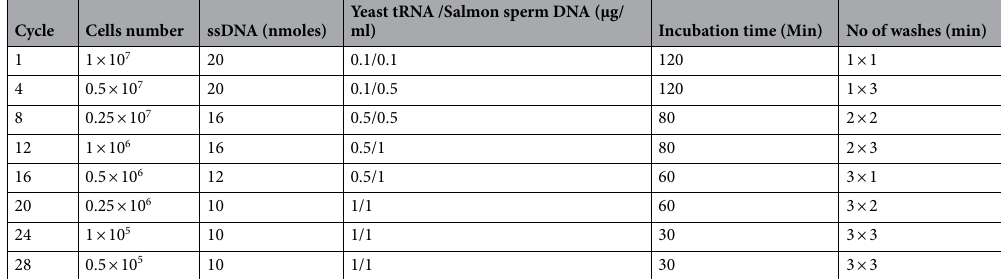
Cycle Cells number ssDNA (nmoles)